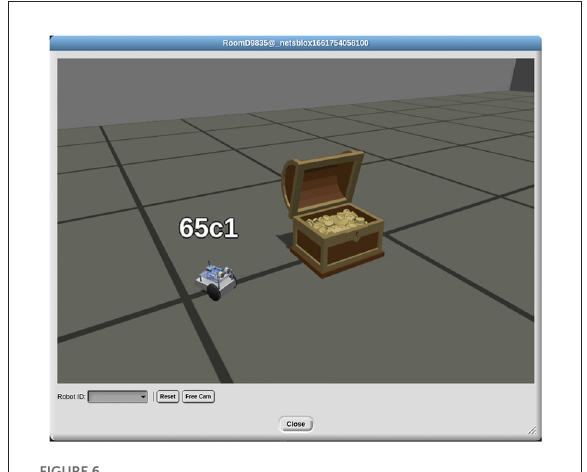
FIGURE6 Visual of success state in “treasure hunt” environment. The treasure chest was not revealed until the robot moved to its location and a “dig” command was sent to it.